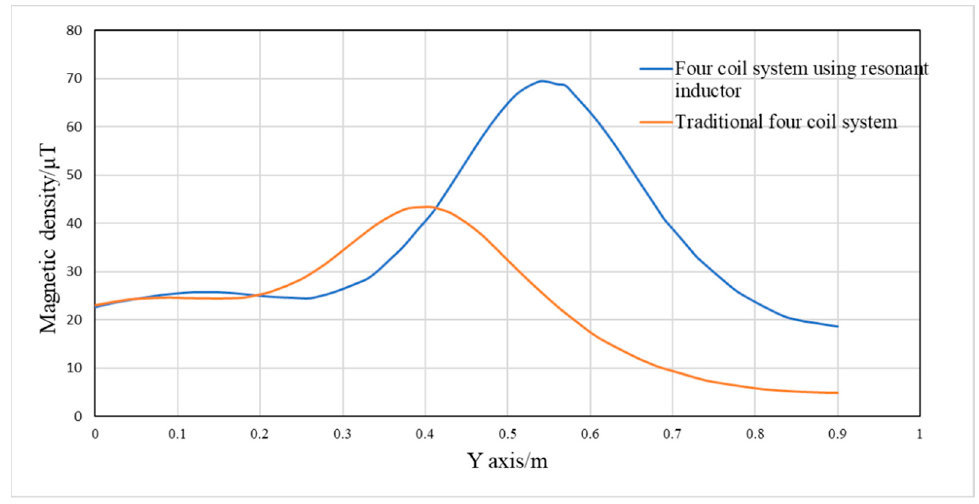
Figure 11. Distribution of magnetic flux density in four-coil system with y-axis direction.